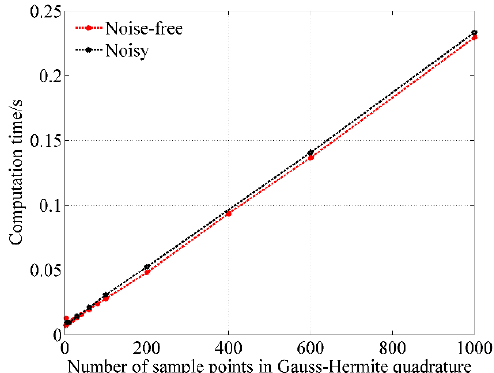
Figure 4. Change of the mean computation time with the number of sample points.